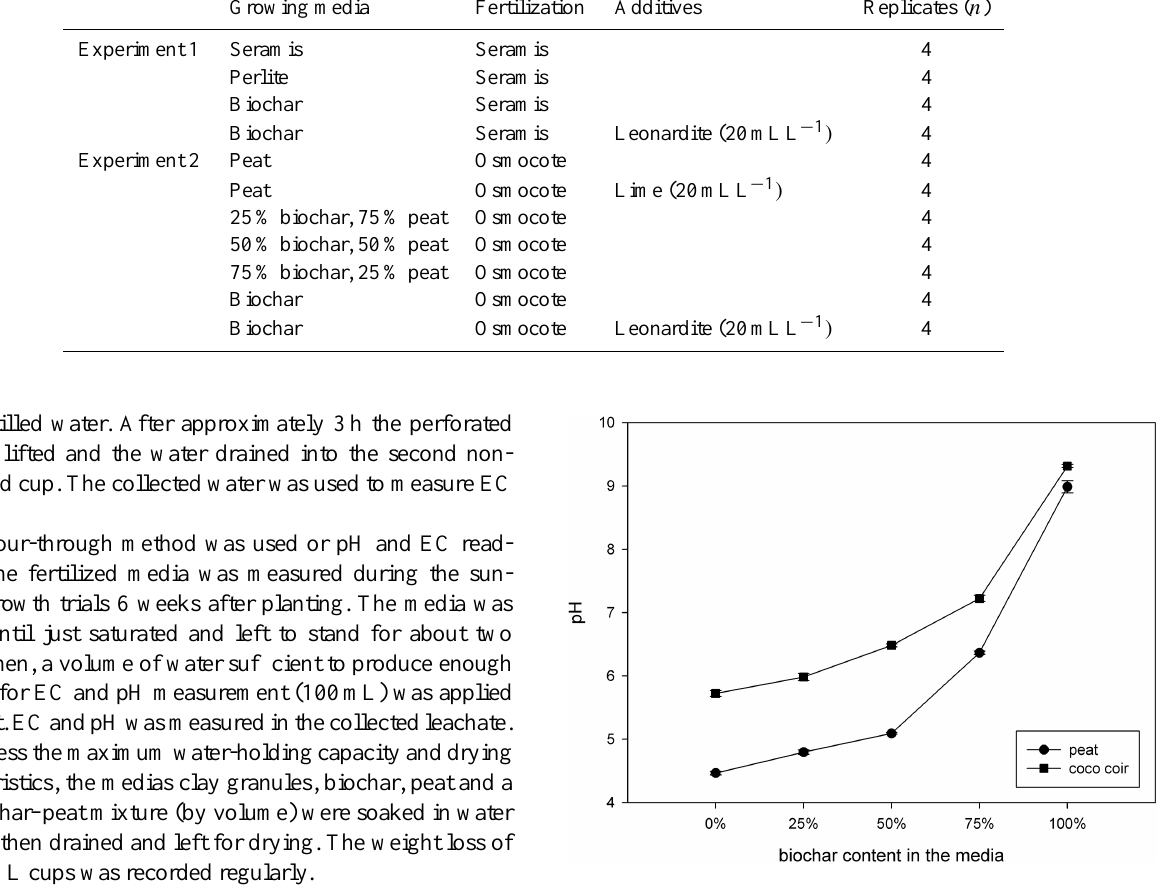
Figure 1. Changes in pH with increasing rates of biochar added to peat or coconut coir ( n = 3, error bars: standard